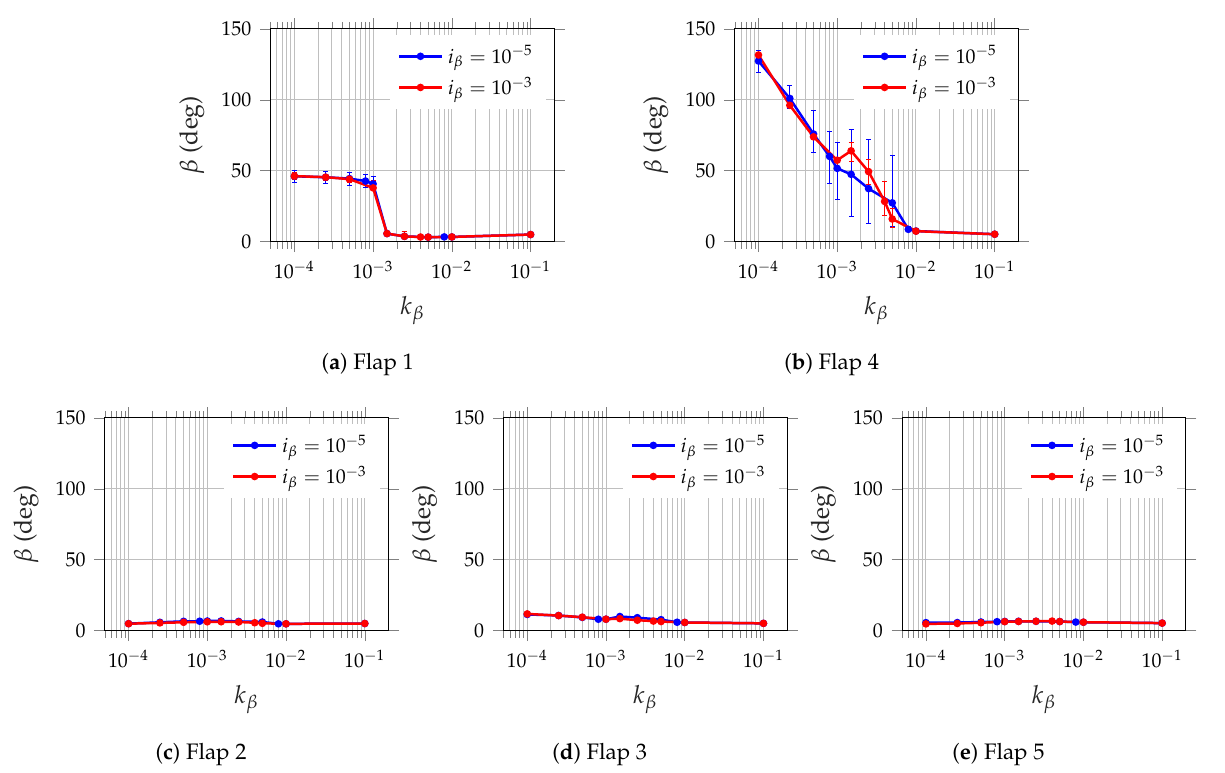
Figure 7. Mean flap deflection with amplitude of oscillations (denoted by vertical bars). around 45 ◦ . On the other hand, flap 1 is largely undeployed for k β > 0.001. Now, we 219